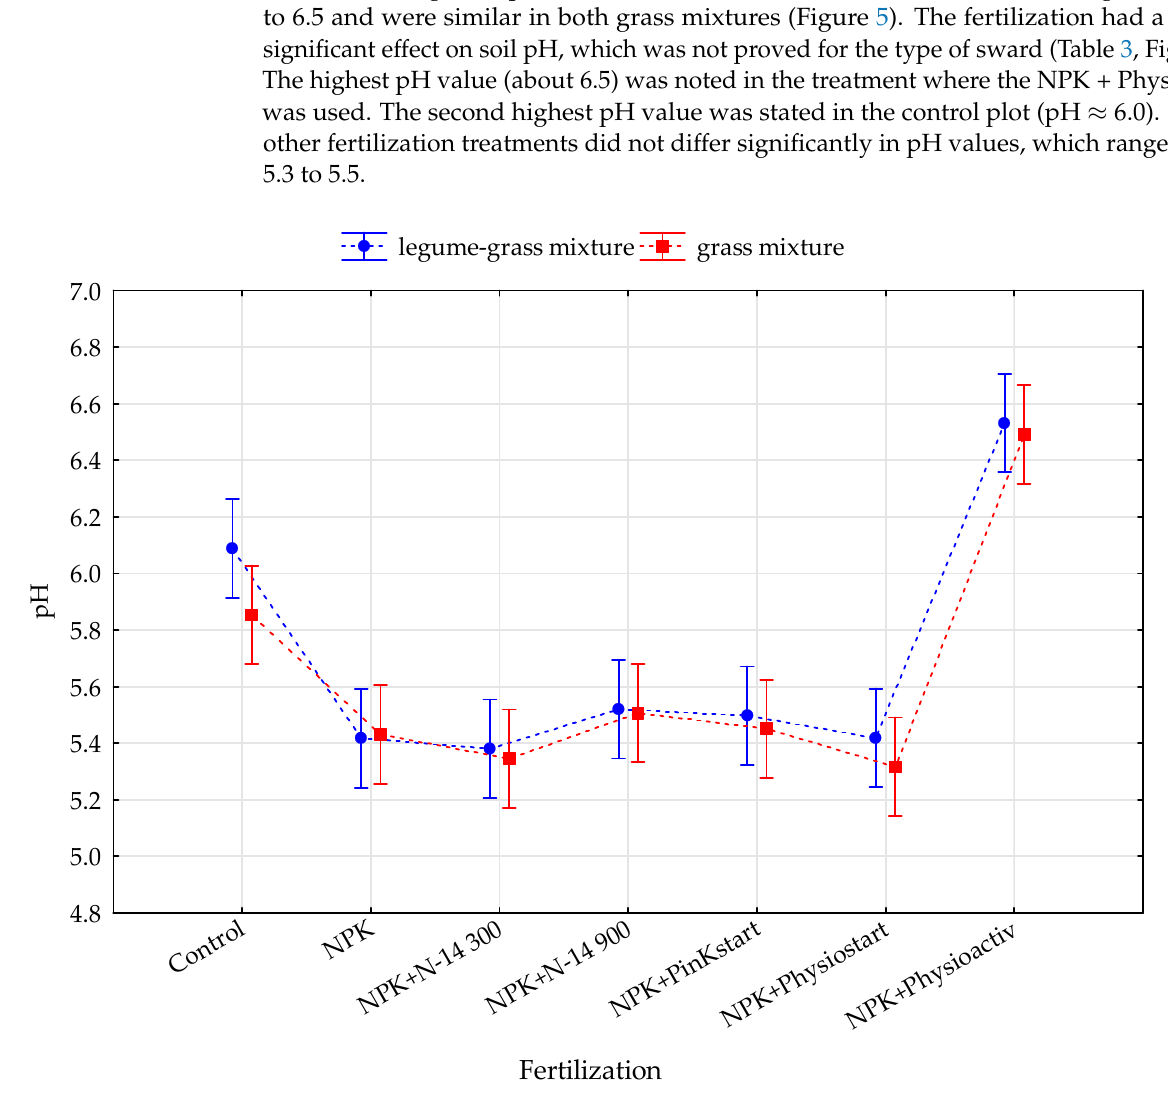
Figure 5. Soil pH values in 2018–2019 (estimated marginal means and 95% confidence intervals in each experimental combination).